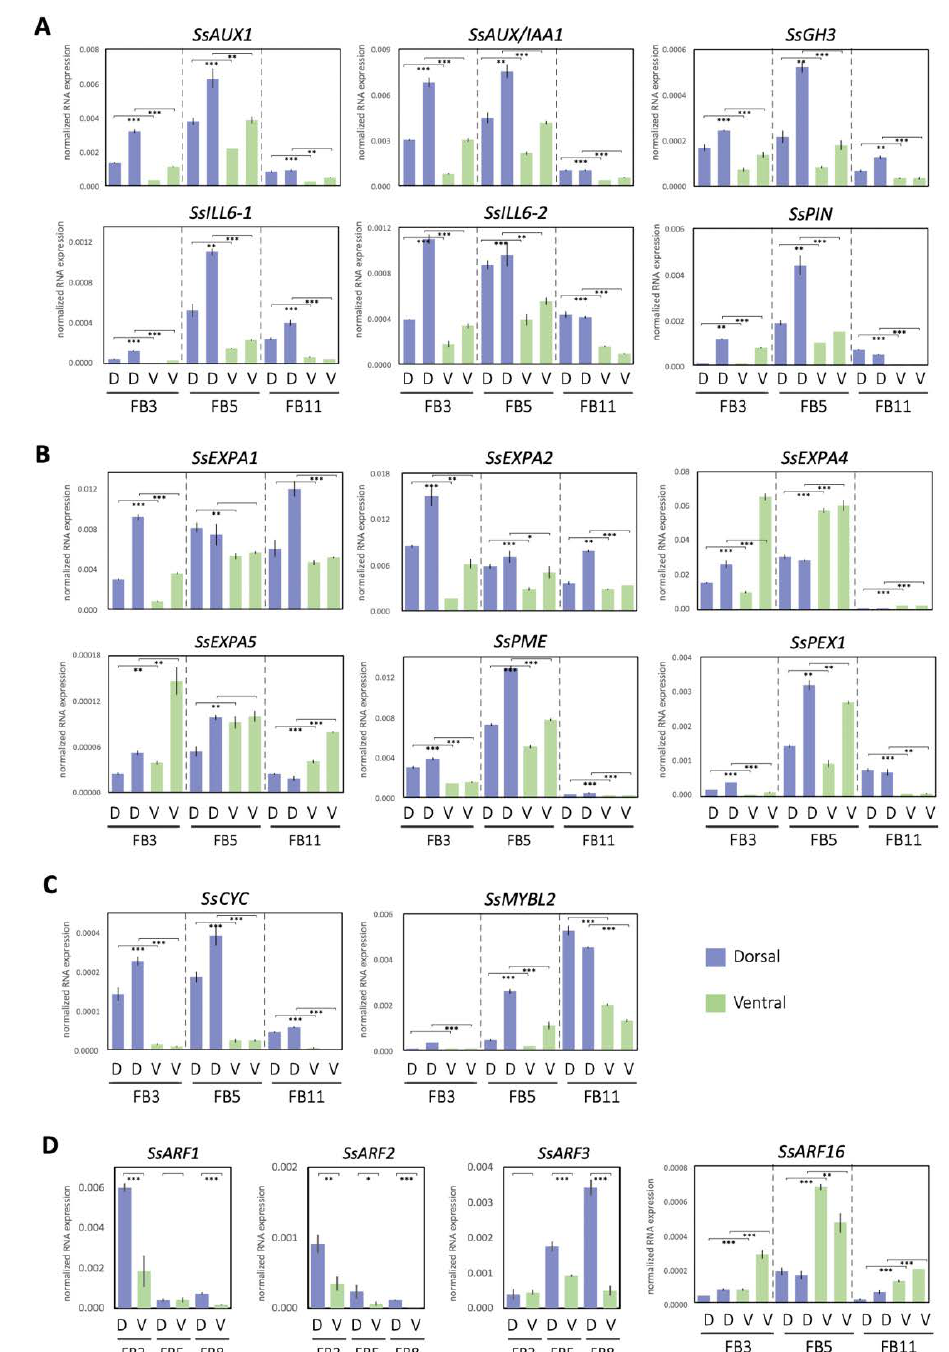
Figure 5. Expression patterns of asymmetric petal DV-DEGs at developmental stages FB3, FB5, and FB8/11, validated by qRT-PCR. DEGs involved in processes of annotating ( A ) the auxin pathway, ( B ) cell wall modification, ( C ) floral symmetry, and ( D ) auxin response factors. D, dorsal petals; V, ventral petals. Data in ( A – D ) are the mean values from two independent experiments, except for SsARFs , which is from three independent experiments. The mean values ± SD are from three technical repeats. Statistical analysis between the paired dorsal and ventral petal samples was determined by Student’s paired t test. Paired samples are connected by lines bracketed at both ends. Statistical analysis between the paired dorsal and ventral petal samples was determined by Student’s t test. * p < 0.05, ** p < 0.01, *** p < 0.001.